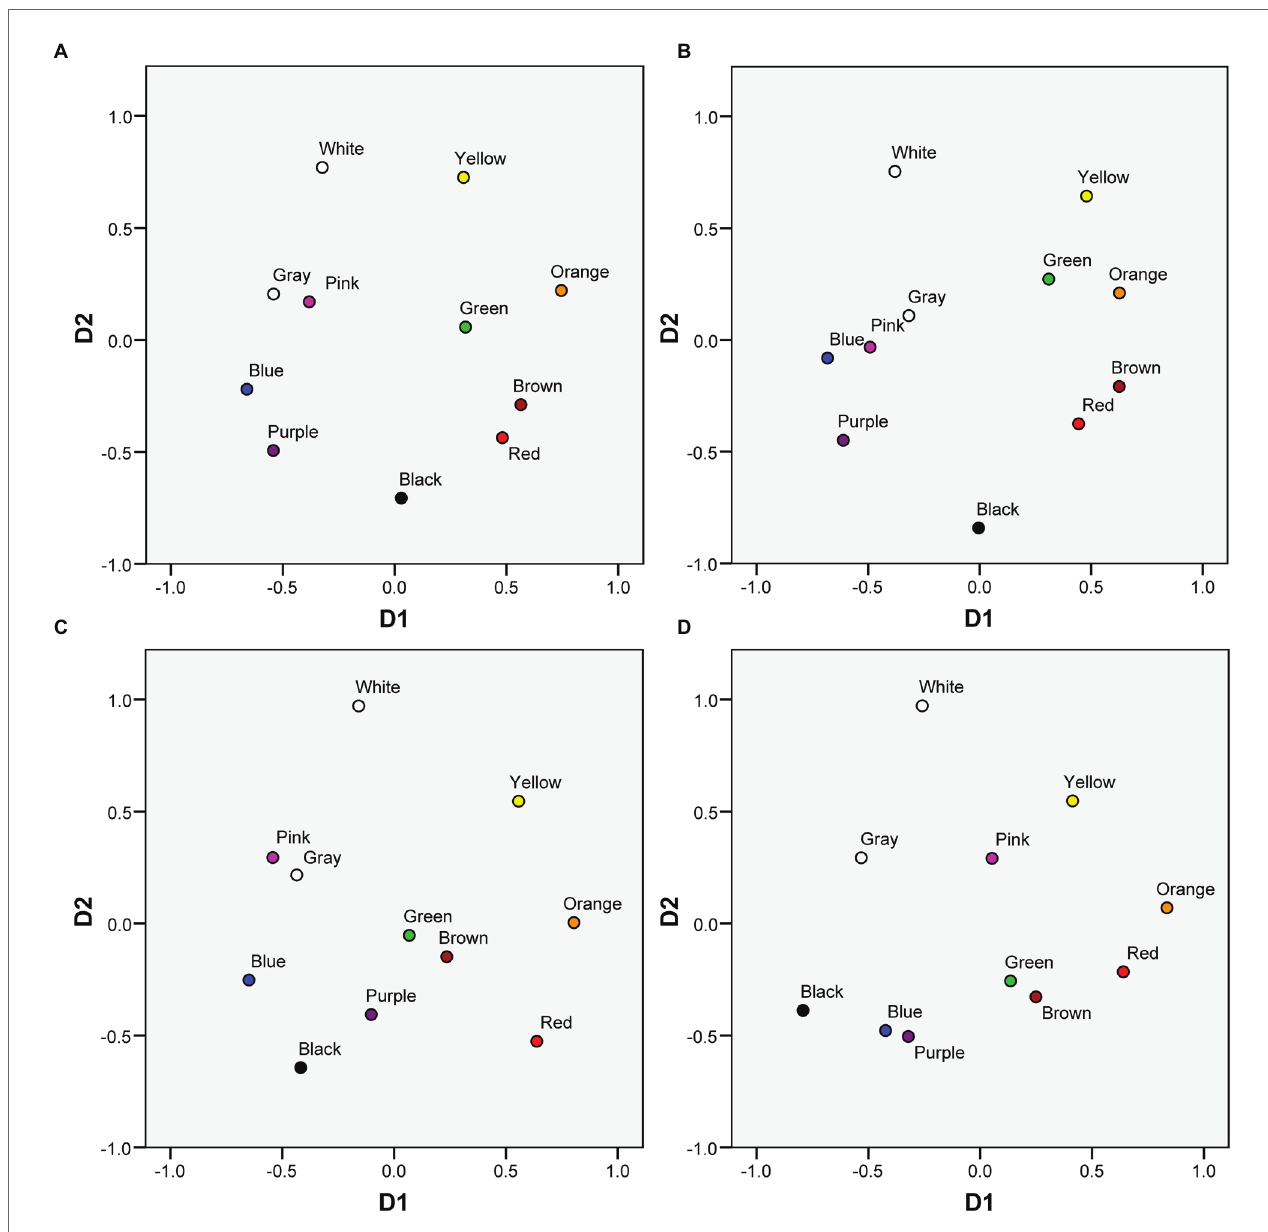
FIGURE 1 | Color planes corresponding to multidimensional scaling (MDS) solutions for protanopes and deuteranopes derived from the mapping and the verbal tasks. (A) Protanopes, pointing task. (B) Protanopes, verbal task. (C) Deuteranopes, pointing task. (D) Deuteranopes, verbal task. (A,C) Colored versions of Figures 3A,B in Lillo et al. (2014; reproduced with permission). (B,D) Represent the transformations applied to the original MDS solutions obtained from the verbal task in order to maximize the global correlation between the 2D MDS solutions derived from both tasks (see text for